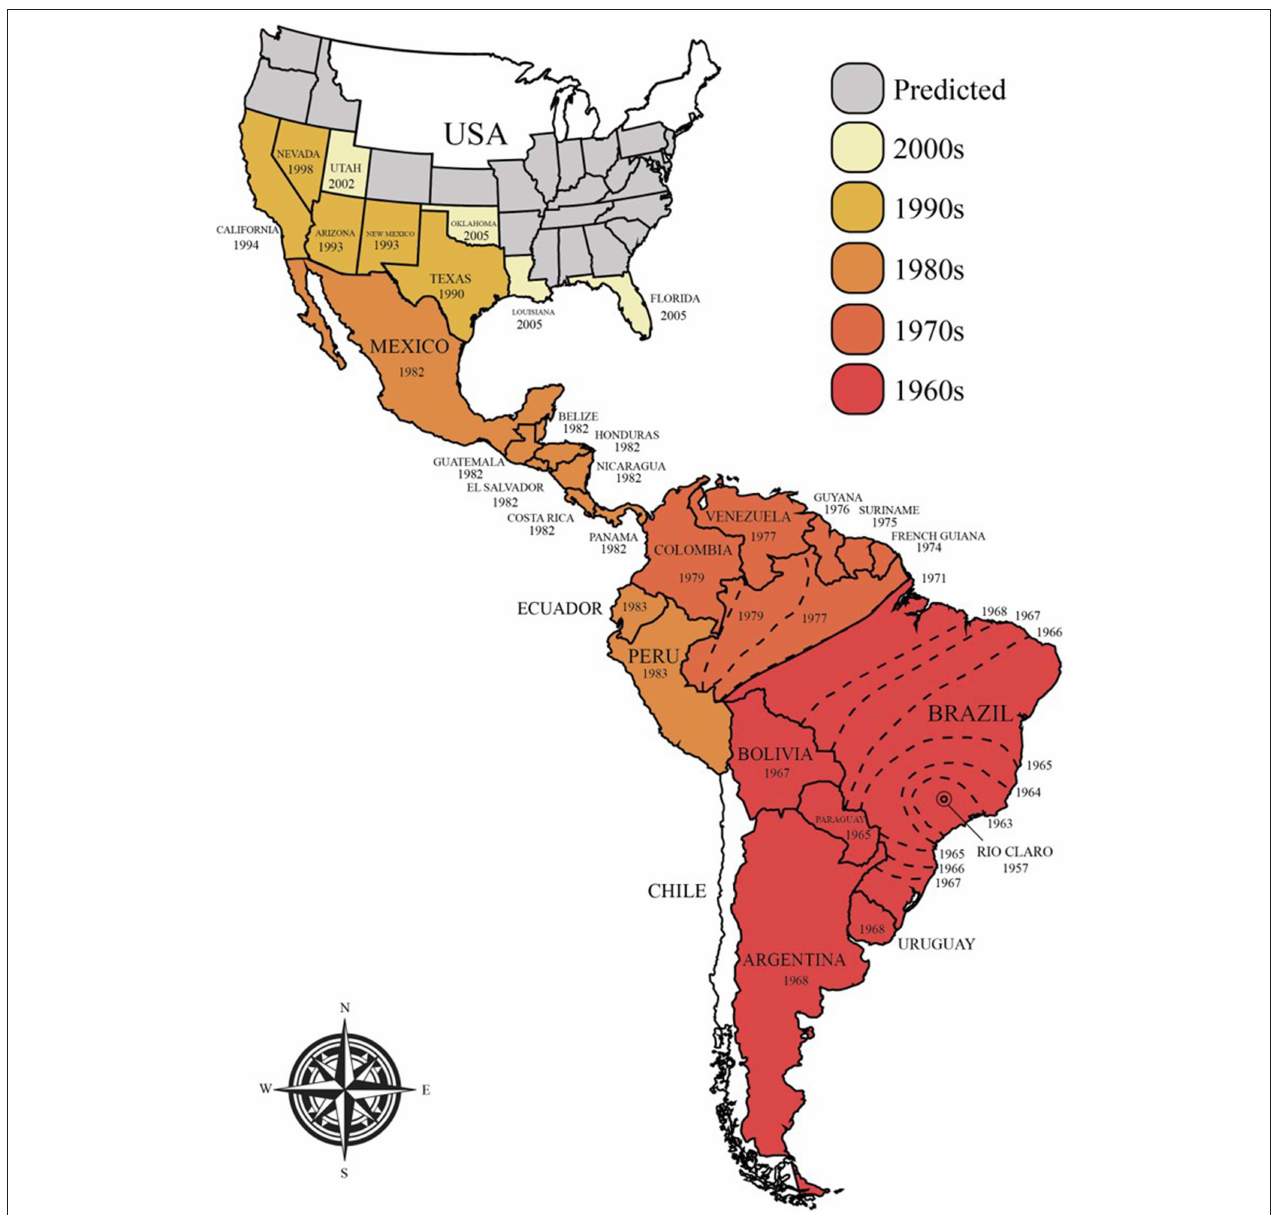
FIGURE 1 | Current and predicted future spread of Africanized honey bees in the